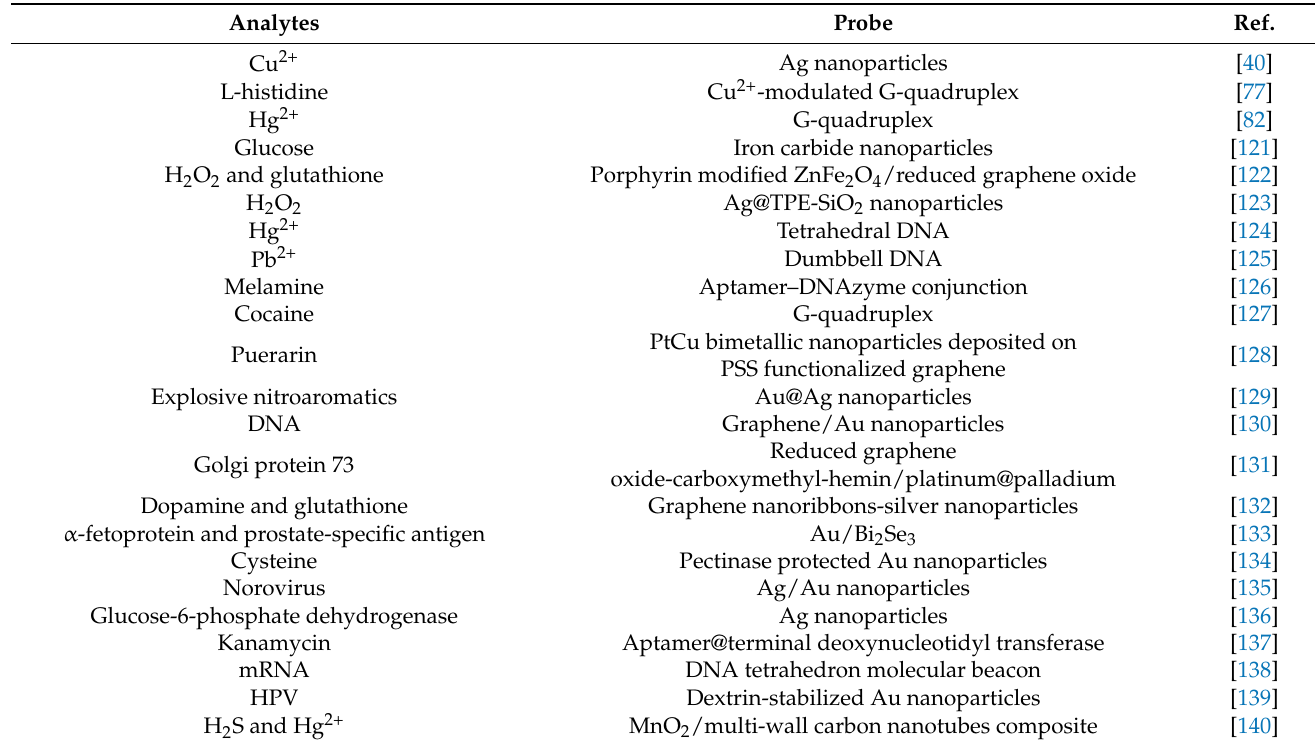
Table 2. A list of sensor analytes and their respective